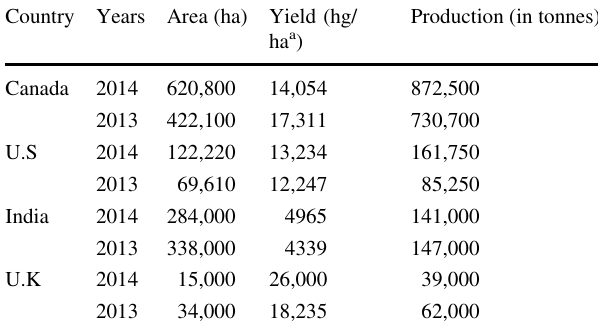
Table 1 Recent data on Linseed production in major countries Country Years Area (ha) Yield (hg/ ha a )